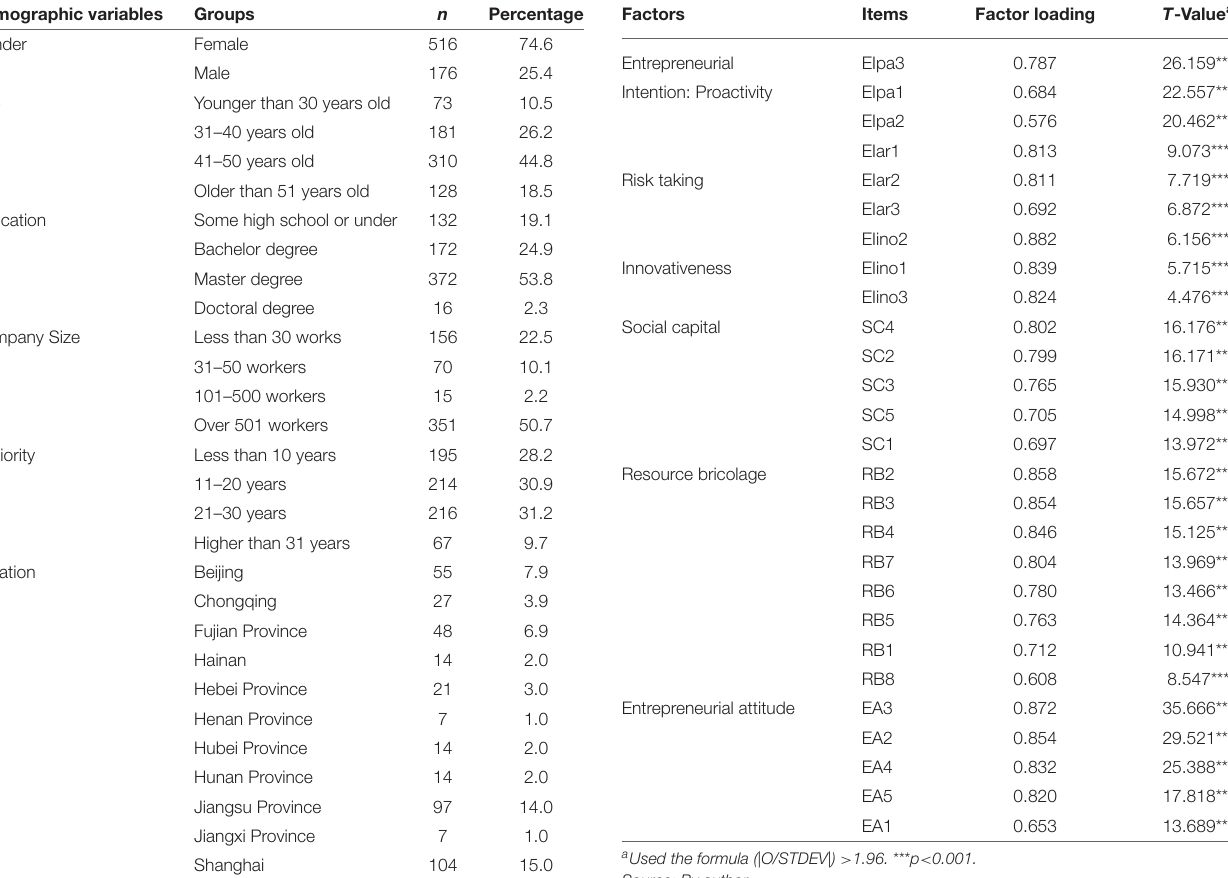
TABLE 3 | The exploration factor analysis of the developed instrument ( n = 692). Factors Items Factor loading